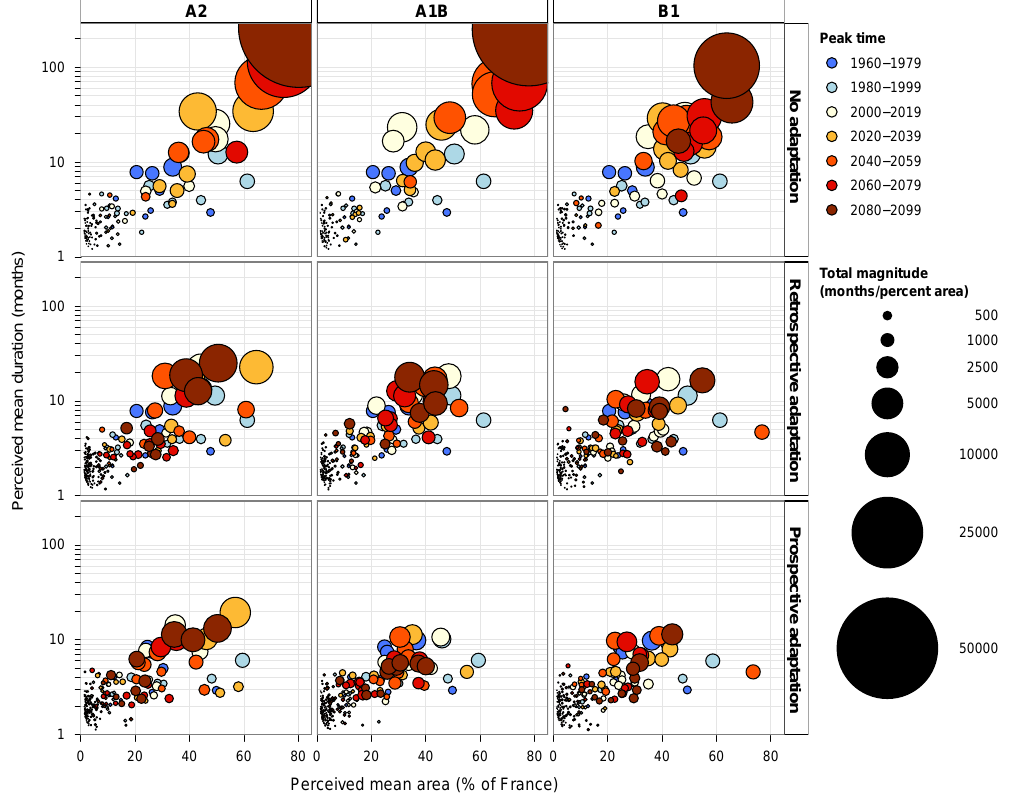
Fig. 9. As for Fig. 7, but for short agricultural droughts, as defined by